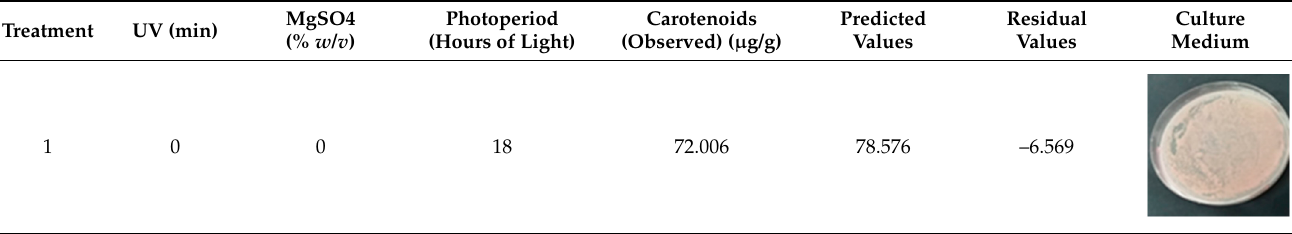
Table 3. Total carotenoids predicted using a Box–Behnken 3 3